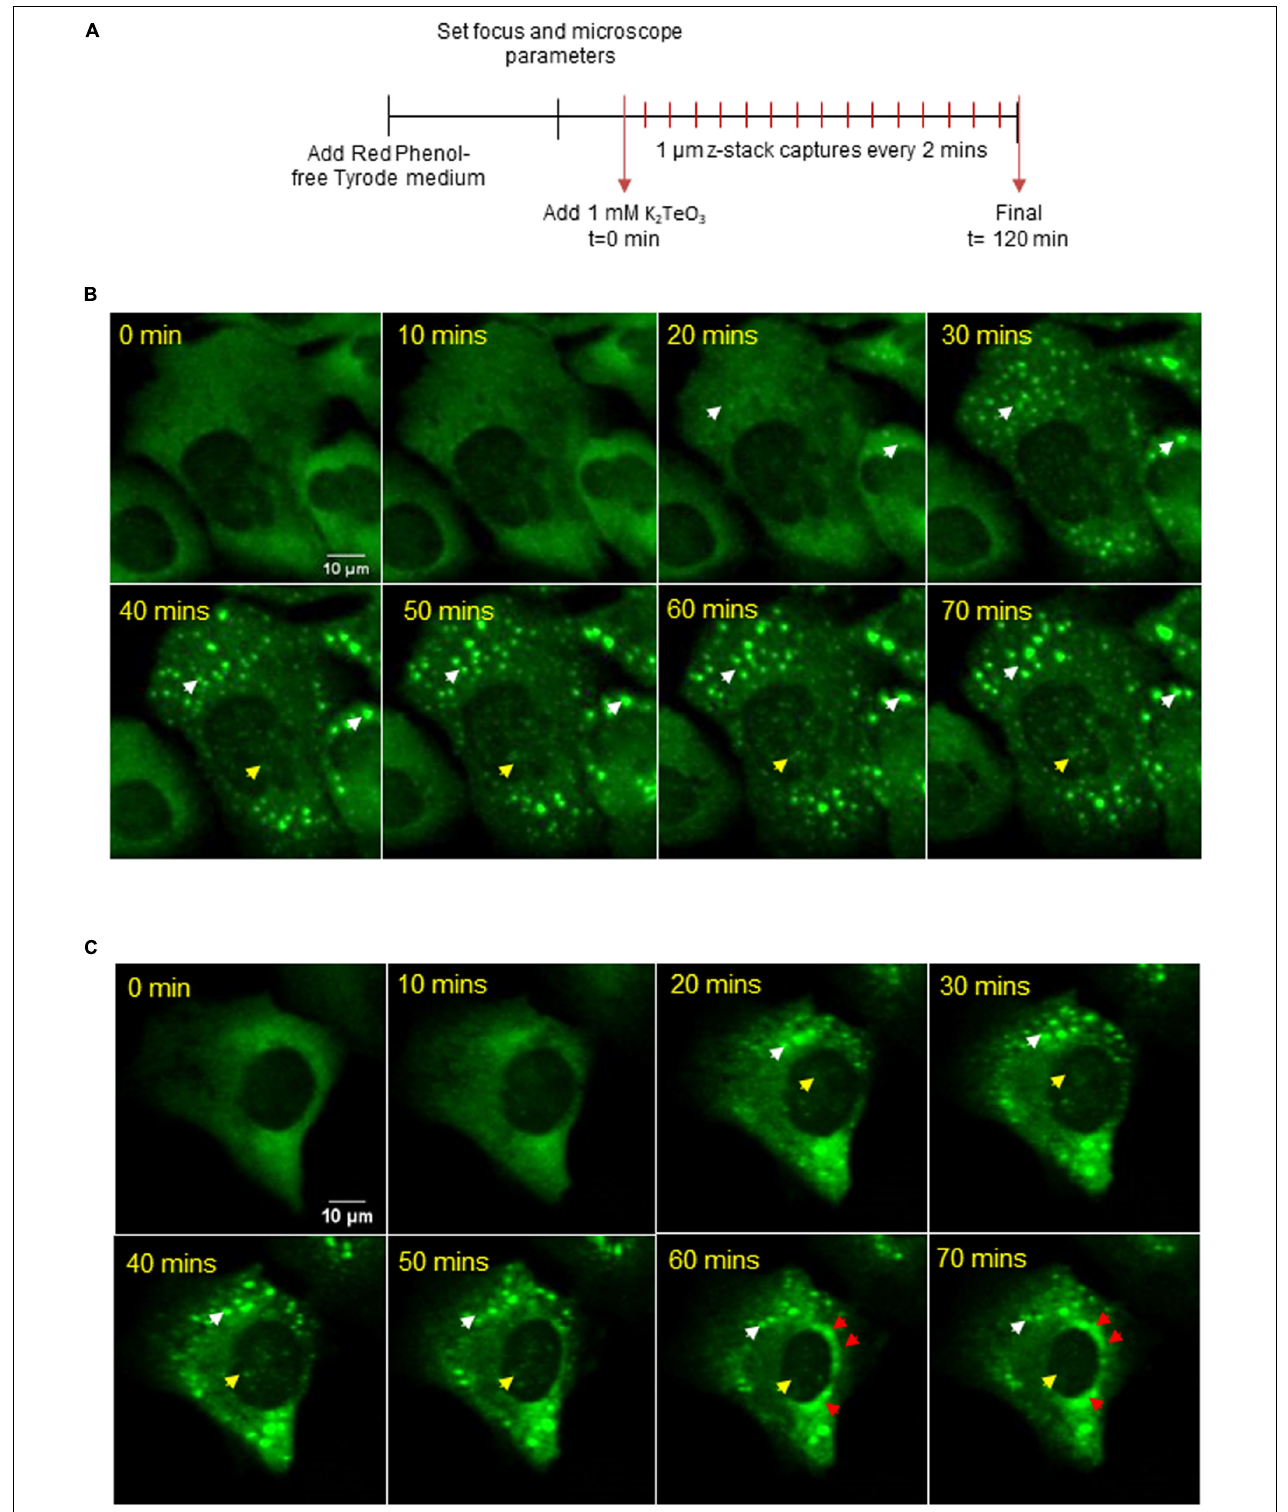
FIGURE 3 | (A) U2OS GFP-G3BP-1 were observed by a confocal microscope under 1 mM tellurite treatment for 2 h. 12 z-stacks of 1 µ m were acquired every 2 min (see Supplementary Video 1 ). Representative images for a 3D reconstruction of two different observed phenotypes (B,C) of GFP-G3BP-1 accumulation dynamics are shown (up to 70 min). White arrowheads indicate the presence of cytoplasmic GFP-G3BP-1 aggregations while yellow arrowheads indicate the assembly of GFP-G3BP-1 in the nucleus. The accumulation of GFP-G3BP-1 in a perinuclear zone is indicated by red arrowheads (bottom panel).